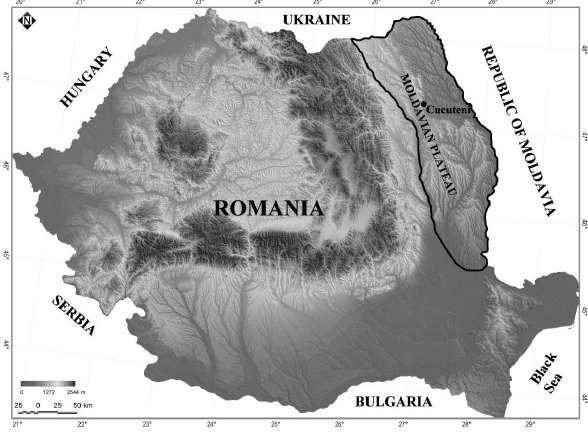
Fig. 1. The geographical location of the Cucuteni-Baiceni gullies and plateau in Romania and Moldova.